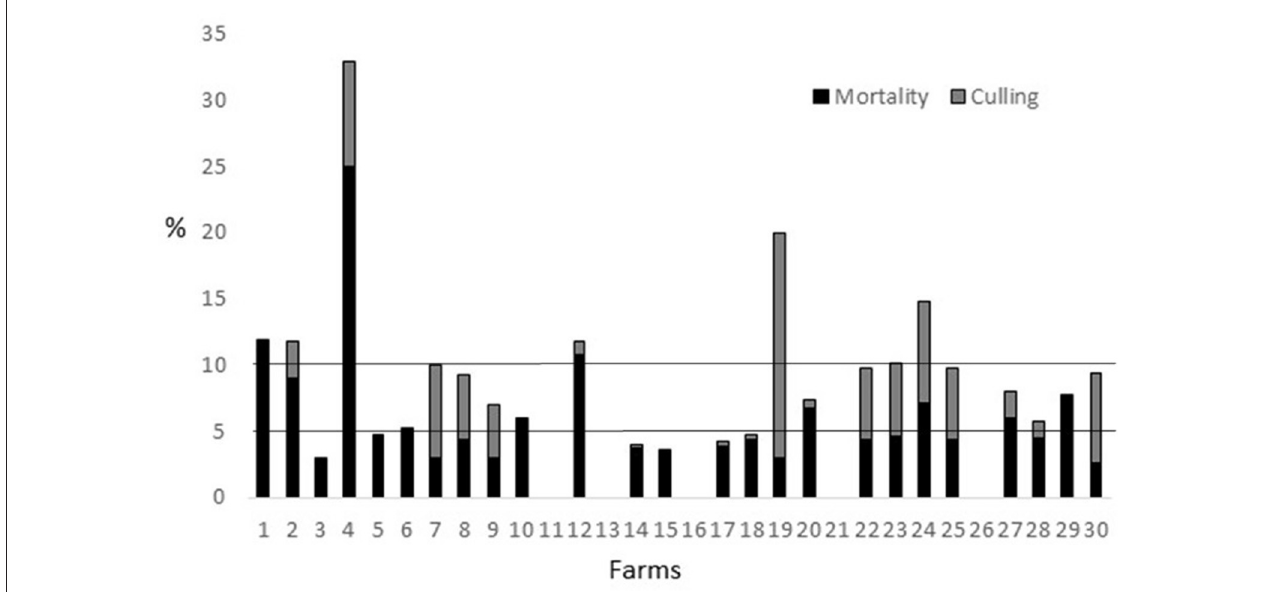
FIGURE 2 | Percentage of mortality (black part of the bar; %) and percentage of culling (gray part of the bar, %) registered during a period of 3 months in the 30 Spanish farms studied during 2019. The absence of a bar (black, gray, or both) means absence of data records for this farm.